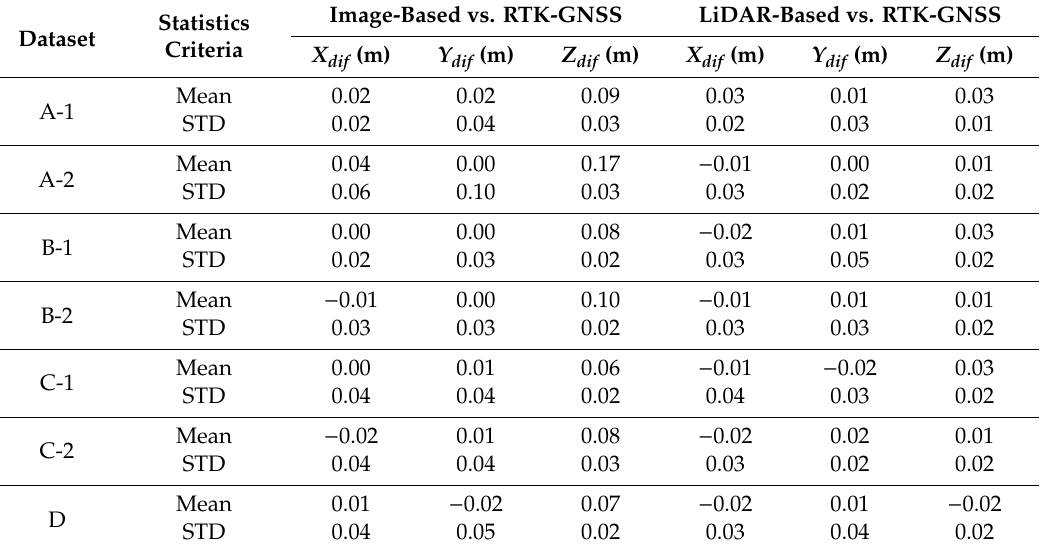
Table 4. Mean and STD of the di ff erences between image-based / LiDAR-based and real-time kinematic-global navigation satellite systems (RTK-GNSS) coordinates of the twelve checkerboard targets for the seven